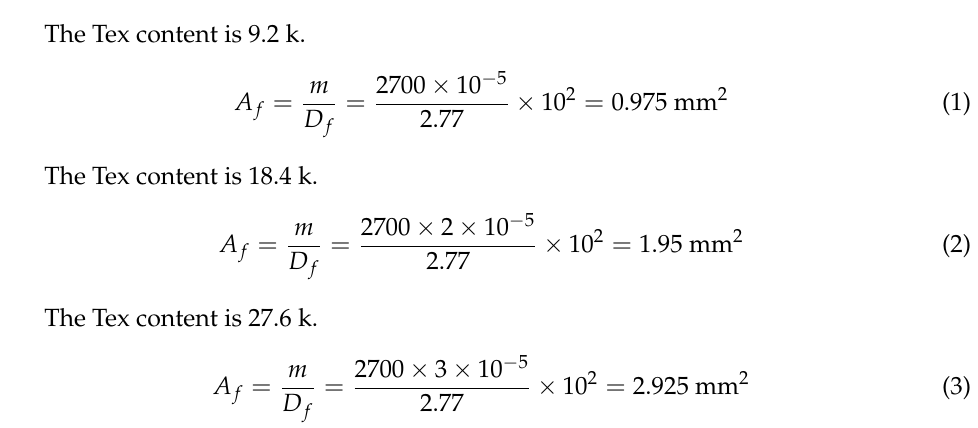
Table 3. Equivalent radius of fiber bundles with different Tex contents.